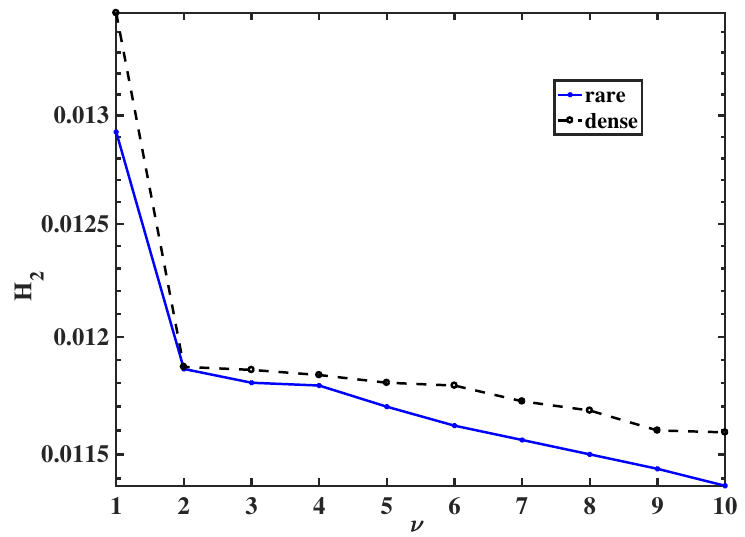
Figure 1. Relative H 2 -norm of the approximation error versus the approximation order ν for rare/- dense interpolation points for the